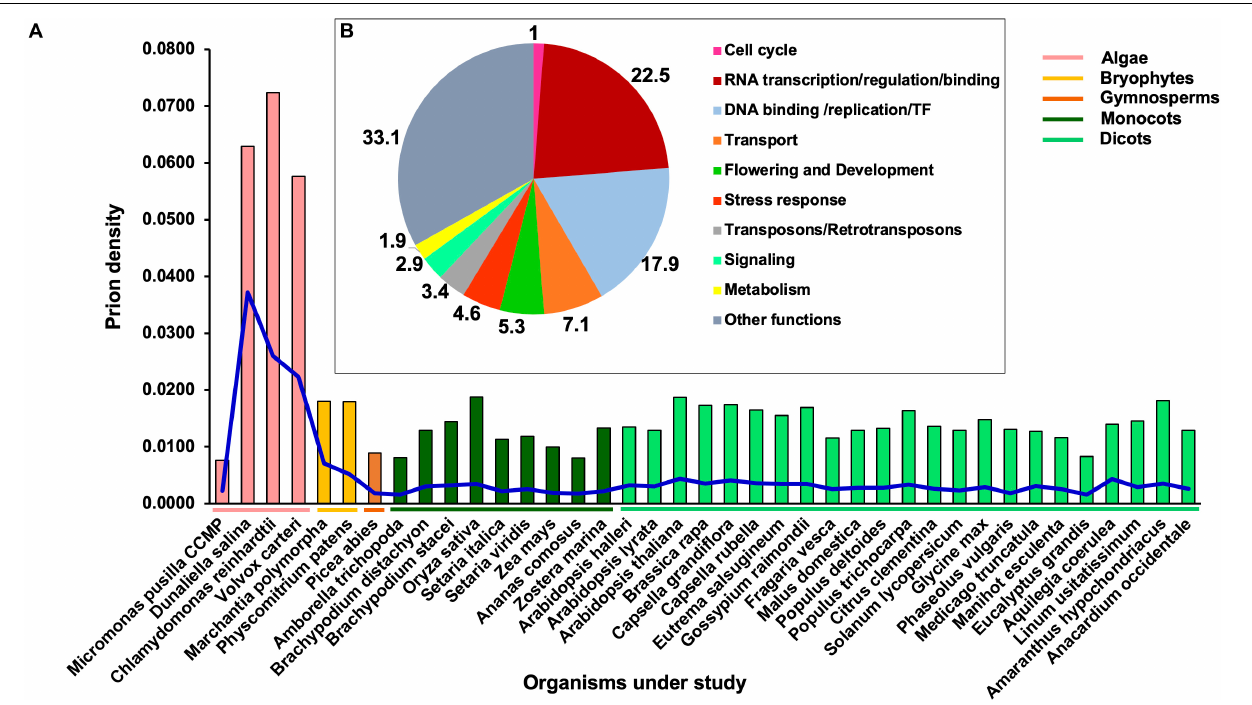
FIGURE 1 | Distribution of prion-like proteins (PrLPs) across the plant kingdom. (A) Bars show densities (PrLP count/proteome size), blue lines show a specific prion density at a threshold COREscore value of 25 as obtained through prion-like amino acid composition (PLAAC) software analyses. (B) Ten functional categories of PrLPs from 39